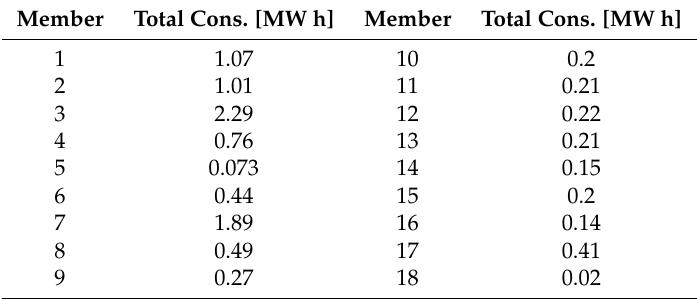
Table 1. Total electricity consumption of the 18 member companies during the pilot (July 2019–June